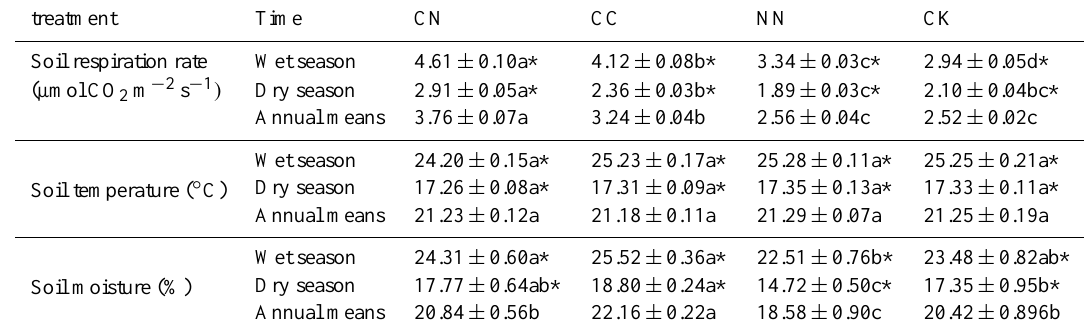
Table 3. Mean soil respiration rate, mean soil temperature at 5cm below the soil surface and mean soil moisture of the top 5cm soil layer under different CO 2 and N treatments (mean ± standard deviations). Standard deviation within each treatment showed the dispersion among open–top chambers employed for each treatment. n = 3 for the CN and CC treatments, n = 2 for the NN treatment and CK. Mean values within a row with different lowercase letter have significant treatment differences at α =0.05 level. Means values within each column indicated by the asterisk show significant seasonal differences at α =0.05 level. The treatments are: CK = control, NN = high N, CC = elevated CO 2 , CN = elevated CO 2 + high